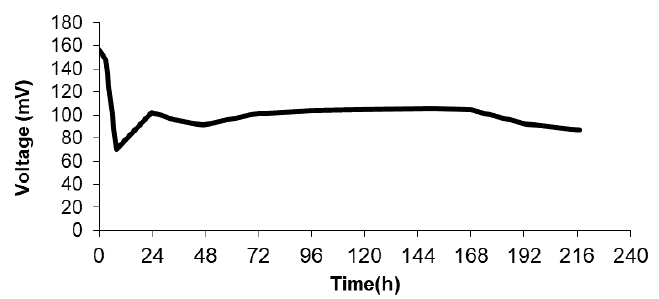
Figure 4. Voltage output in MFC using polymer inclusion membrane based on 70% w / w of [MTOA + ][Cl − ] using white oil refinery wastewater as feedstock.